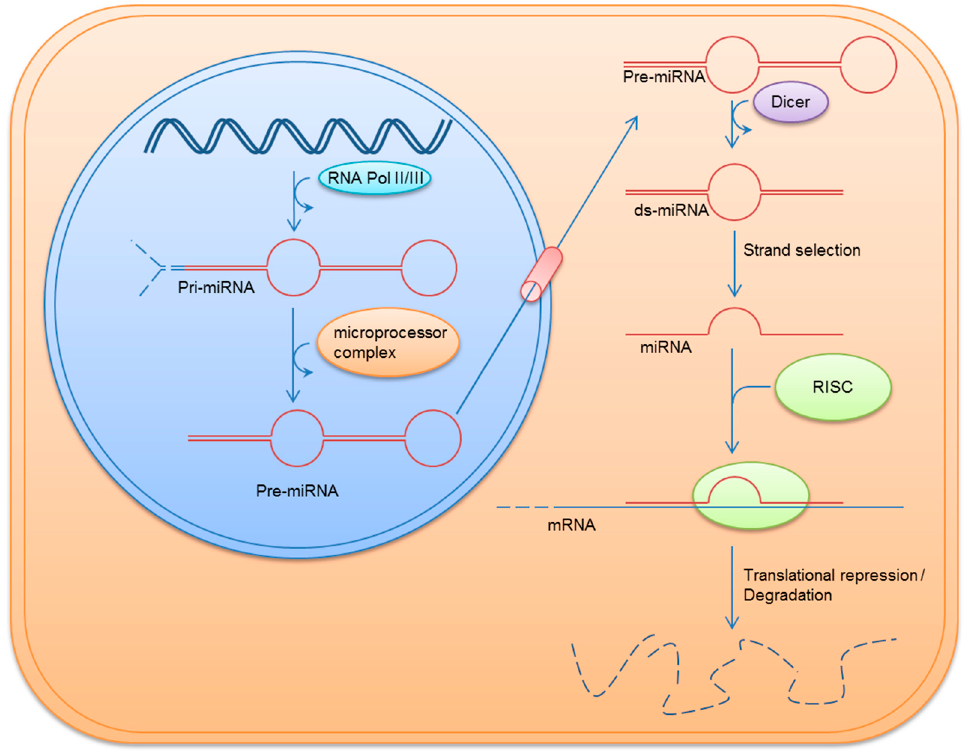
Figure 1. The biogenesis of MicroRNAs (miRNAs). RNA Pol, RNA polymerase; miRNA, microRNA; pri-miRNA, primary miRNA; pre-miRNA, precursor miRNA; ds-miRNA, double stranded miRNA; RISC, RNA-induced silencing complex; mRNA, messenger RNA.